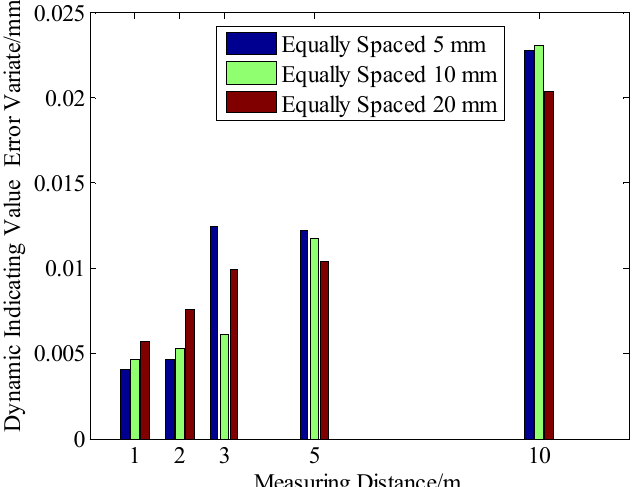
Figure 8. Measurement distance and dynamic display value variable relationship diagram— (equally spaced). Table 1. The dynamic performance of the laser tracker when measuring at different distances and equal spacing.